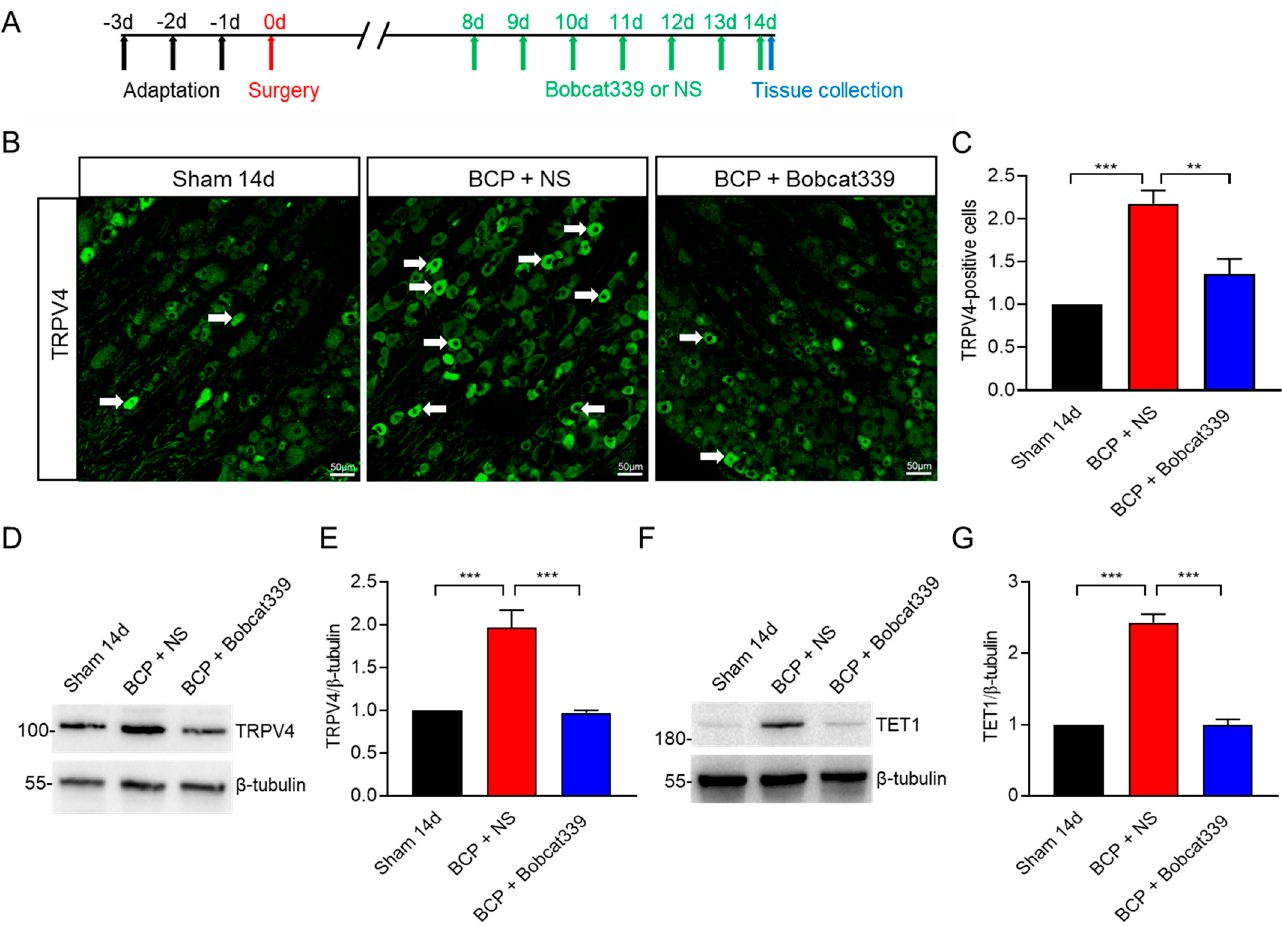
Figure 6. TET1 inhibitor Bob339 downregulated TRPV4 expression in L4 − 6 DRG of BCP rats. ( A – C ) The white arrows represent typical TRPV4 − positive cells. After intrathecal injection of Bobcat339, there were significantly fewer TRPV4 positive cells in the L4 − 6 DRG of BCP rats than in the BCP +